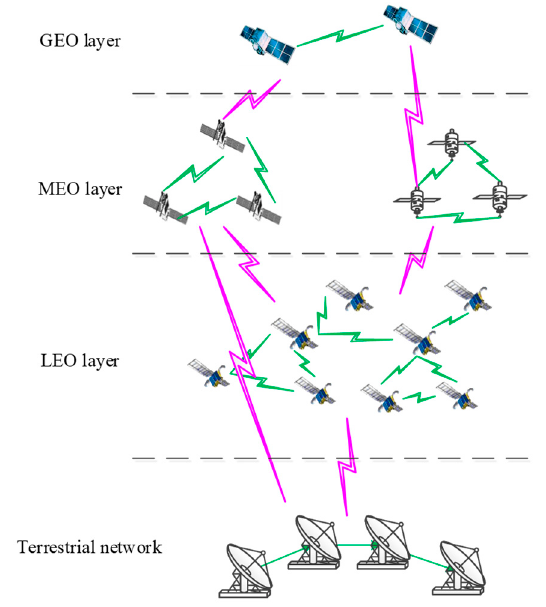
Figure 1. Composition of the space-based information network system.